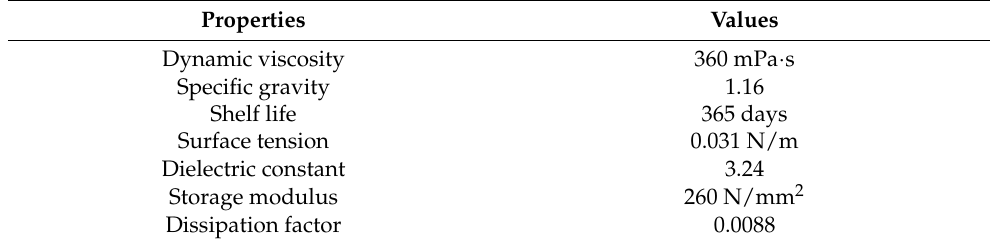
Table 1. Physical properties of functional ink used during the simulation and